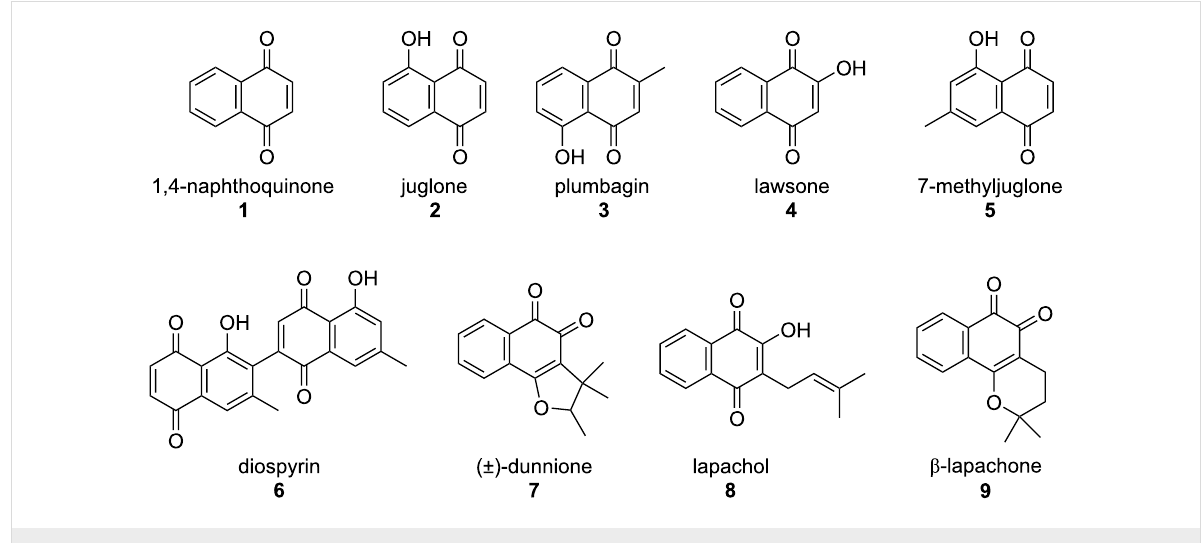
Figure 1: Natural bioactive naphthoquinones.